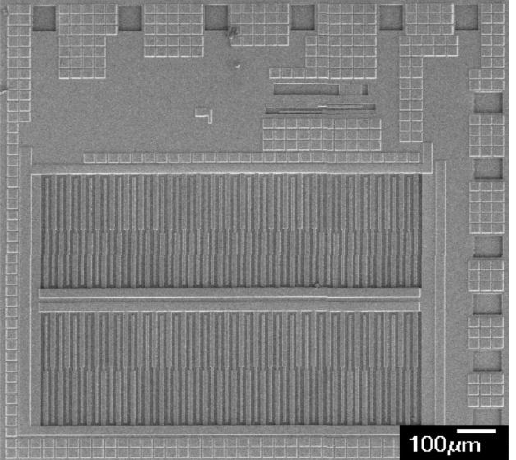
Figure 7. SEM images of the integrated humidity sensor after the wet etching.